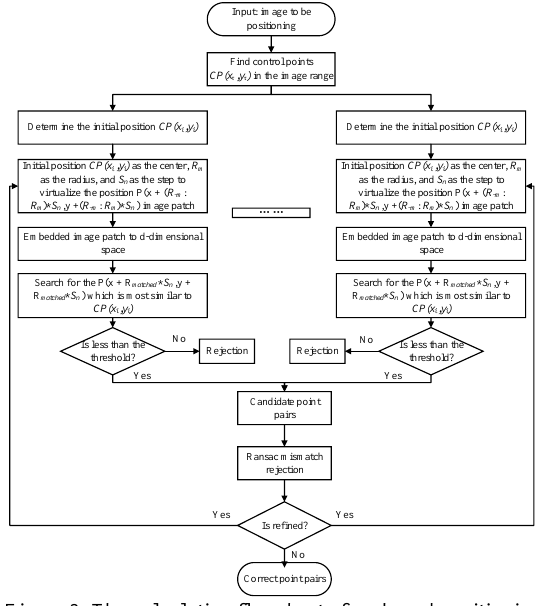
Figure 3. The calculation flowchart of on-board positioning based on GCPs